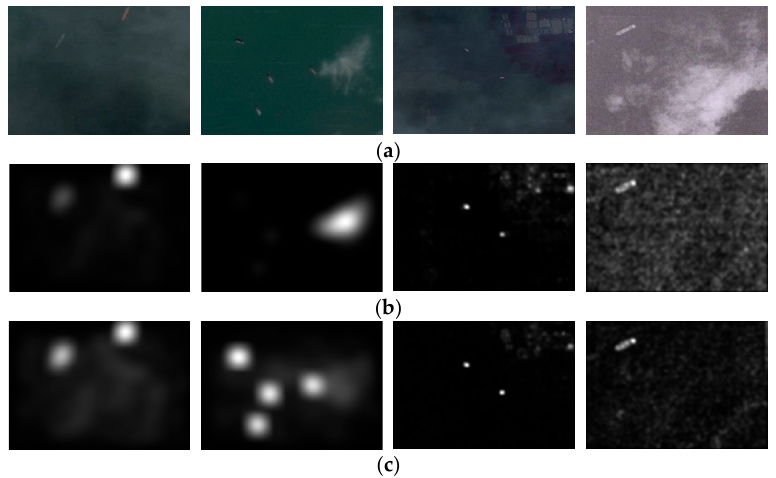
Figure 4. Comparisons between the original and the improved models. ( a ) Input images. ( b ) Original model: (from left to right): Hypercomplex Frequency Domain Transform (HFT), HFT, Phase Quaternion Fourier Transform (PQFT), PQFT. ( c ) Improved model: (from left to right): HFT, HFT, PQFT, PQFT.